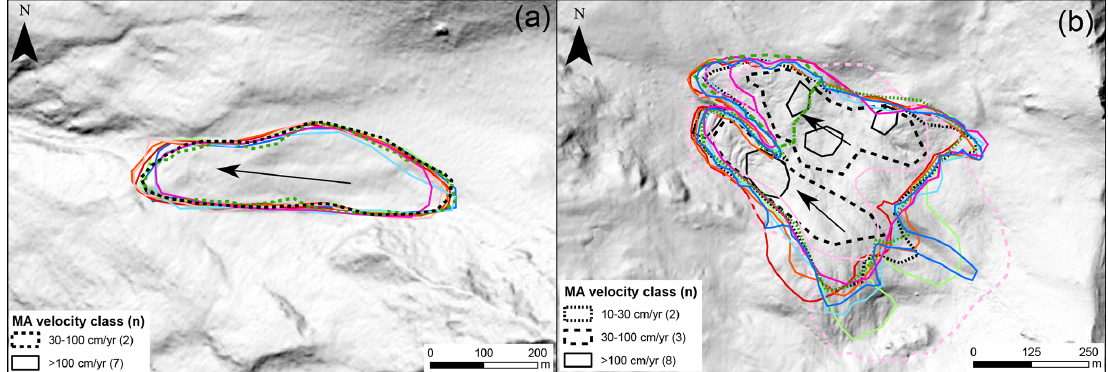
Figure 11. Two examples (a, b) of MAs delineated by nine operators. Hillshade as background from Swisstopo© (https://www.swisstopo. admin.ch; last access: 10 October 2021). The outlines drawn on the simple RoG (a) are very similar, and MAs are classified as > 100cmyr − 1 by seven operators and as 30–100cmyr − 1 by two operators, due to temporal variations in interferograms. According to the mapped MAs, this RoG is classified as myr − 1 or higher (also in agreement to GNSS data) by seven operators and as dmyr − 1 tomyr − 1 by two operators. Greater heterogeneity is observed on RoG affected by larger temporal and spatial variations in interferograms (b) , with more heterogeneous outlines of MAs and different assigned velocity classes ( > 100, 30–100 and 10–30cmyr − 1 ). However, despite the larger heterogeneity, this RoG is classified as myr − 1 or higher by six operators and as dmyr − 1 to myr − 1 by three operators; these kinematic attributes are in line with GNSS data, ranging from about 0.2 to 2myr − 1 . Some related interferograms are included in Figs. S2–S4 of the